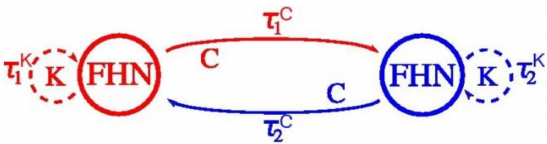
Figure 2. From Reference [45] and adapted from Figure 4 in Reference [20]. Two FitzHugh-Nagumo neuron groups with coupling strength C and internal feedback strength K exhibit different delay times forward and